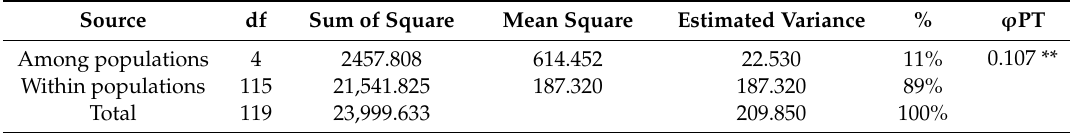
Table 4. AMOVA of molecular variation among and within five populations. Source df Sum of Square Mean Square Estimated Variance % ϕ PT Among populations 4 2457.808 Within